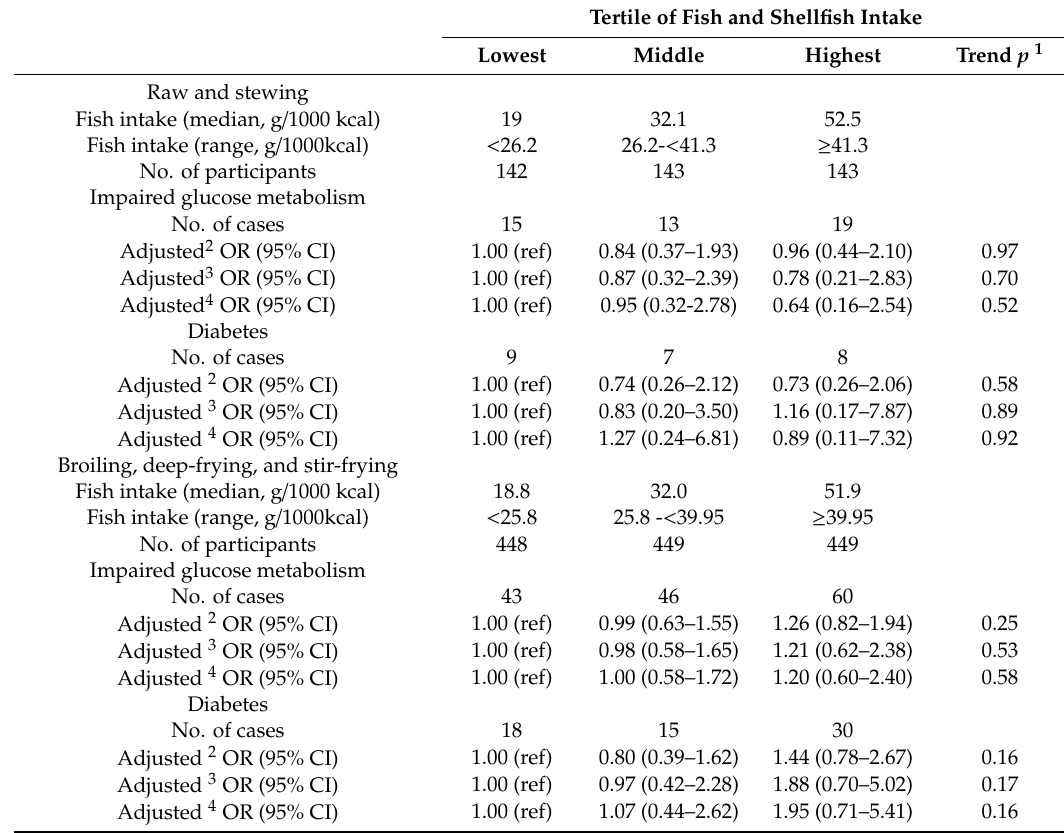
Table 2. Odds ratios (95% CI) of impaired glucose metabolism according to tertiles of fish and shellfish intake by fish cooking